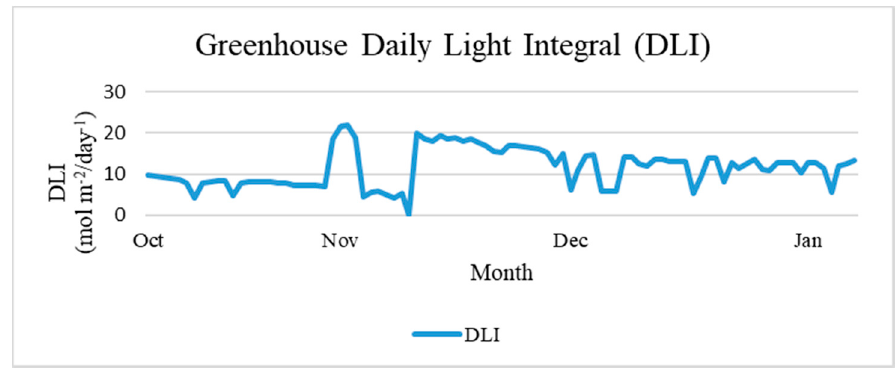
Figure 1. Greenhouse data on maximum and minimum temperature (°C), relative humidity (RH; %), and daily light integral (DLI; mol m − 2 /day − 1 ) obtained during plant growth period from 7 October 2017 to 7 January 2018.